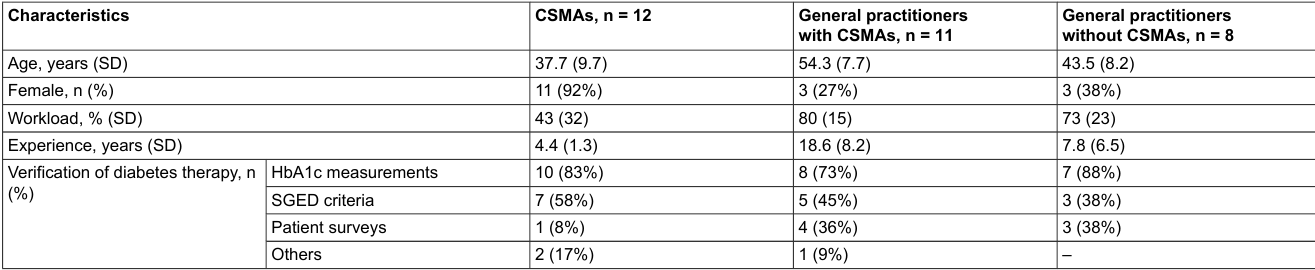
Table 1: Characteristics of CSMAs and